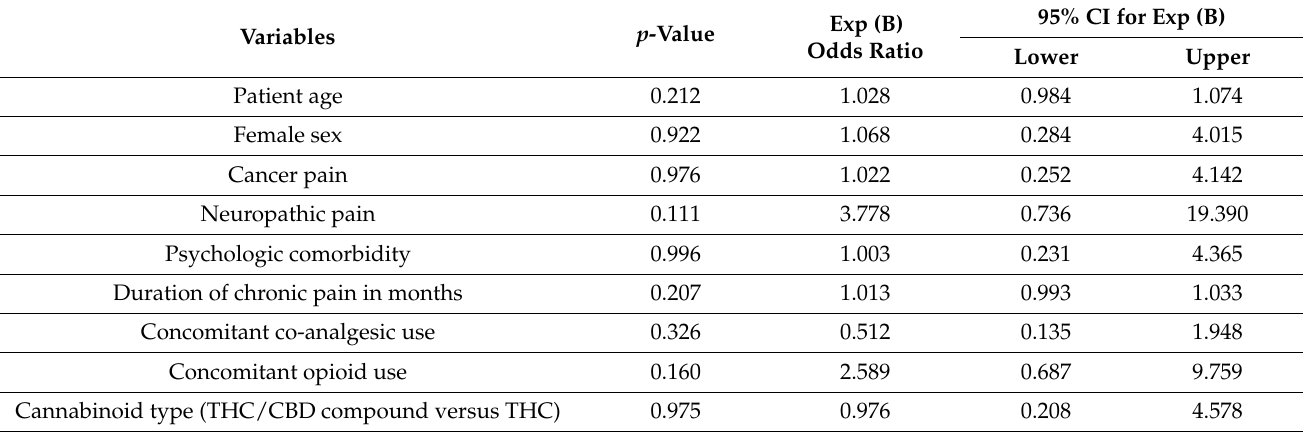
Table 5. Multivariate regression analysis of the association between at least a 30% improvement in emotional distress and different variables under cannabinoid